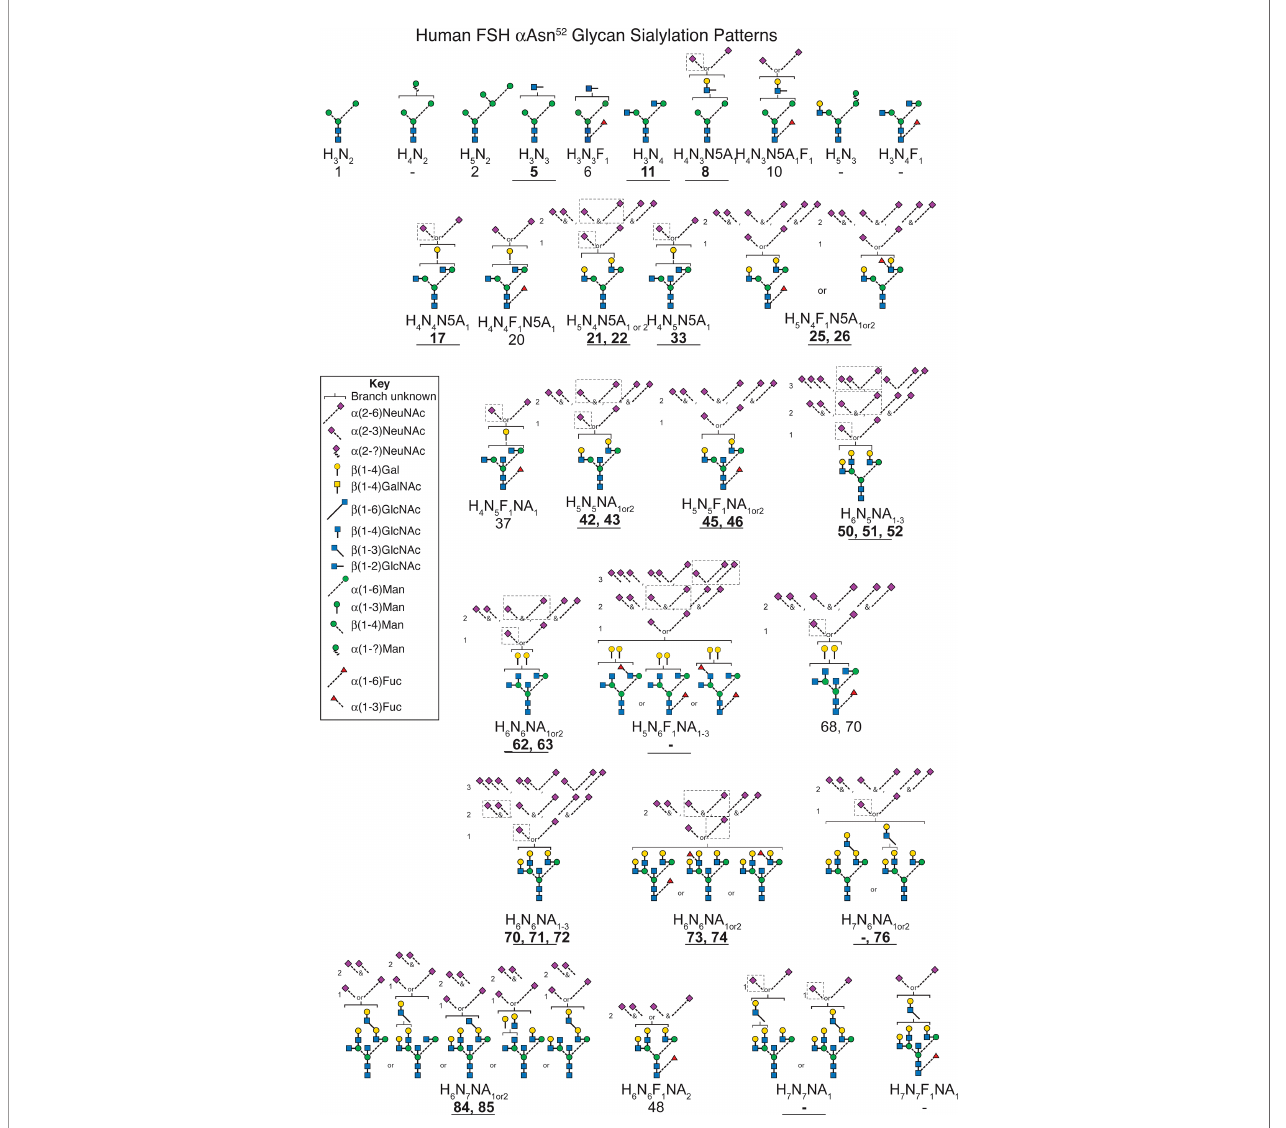
FIGURE 9 | Patterns of sialic acid heterogeneity in the FSH a Asn 52 glycan population. The neutral core glycan structure(s) consistent with composition and CID-MS (bold text, underlined, see Supplement Figures S9A, O ). Sialic acid distributions based on data derived from Figure 7 and Table S19 . Major sialylation patterns indicated by dashed boxes. Glycan masses from Tables 1 and 3 . Glycan structures identi fi ed according to Table 1 . A dash indicates no corresponding glycan in the